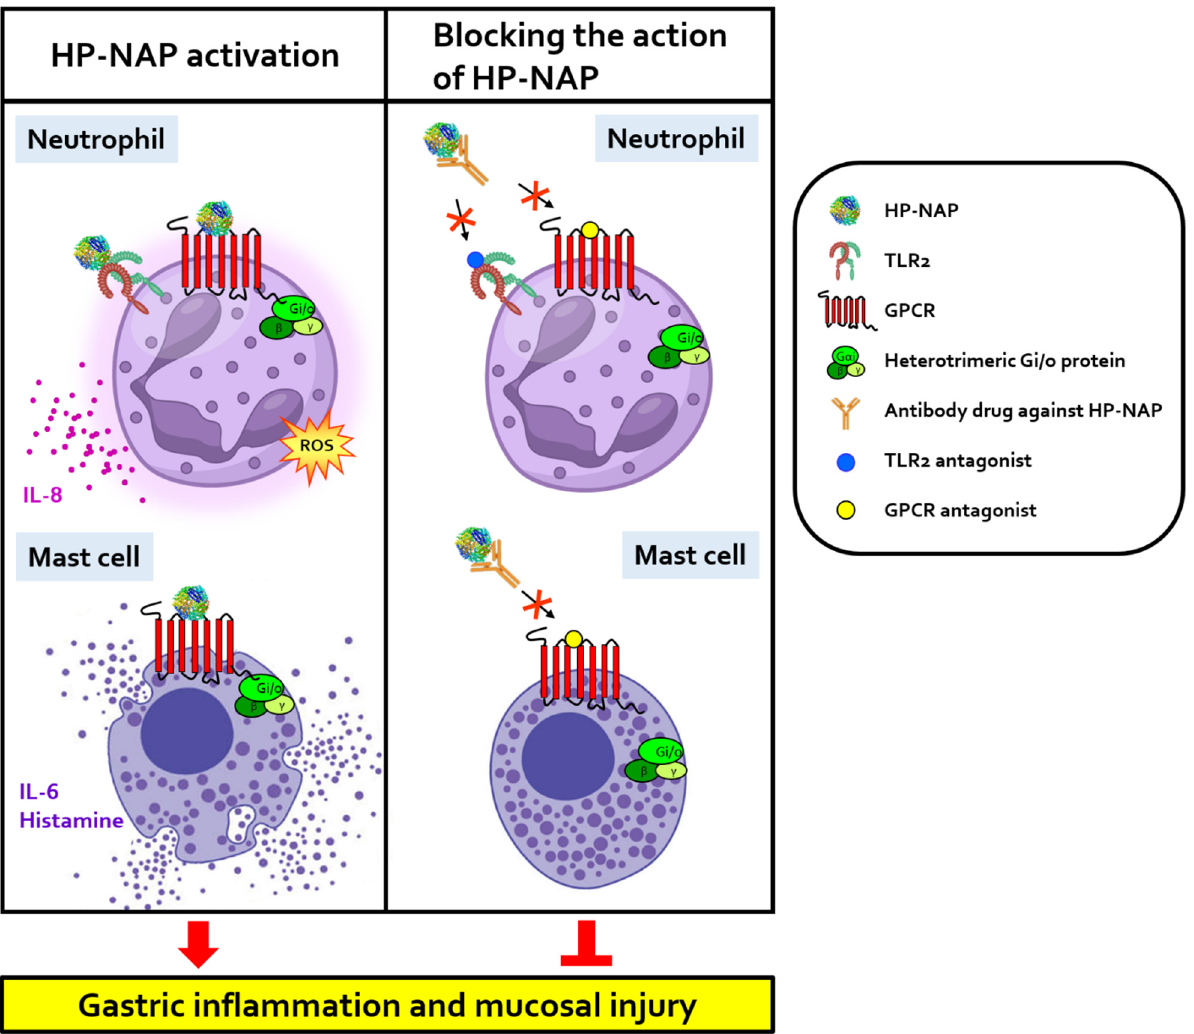
Figure 1. Schematic presentation of HP-NAP as a therapeutic target in the treatment of H. pylori - associated gastric diseases. The binding of HP-NAP to a PTX-sensitive GPCR induces the production of ROS by neutrophils and the secretion of IL-6 and histamine by mast cells. HP-NAP also induces neutrophils to release IL-8 via the activation of TLR2 and PTX-sensitive G proteins. Inhibition of the interactions between HP-NAP and its receptors by antibody drugs against HP-NAP and antagonists specific to the receptors of HP-NAP could relieve the gastric inflammation and mucosa injury caused by H. pylori infection. “ ↓ ” indicates induction; “ ⊥ ” indicates inhibition. GPCR, G protein-coupled receptor; HP-NAP, H. pylori neutrophil-activating protein; IL-6, interleukin-6; IL-8, interleukin-8; ROS, reactive oxygen species; TLR2, Toll-like receptor 2.